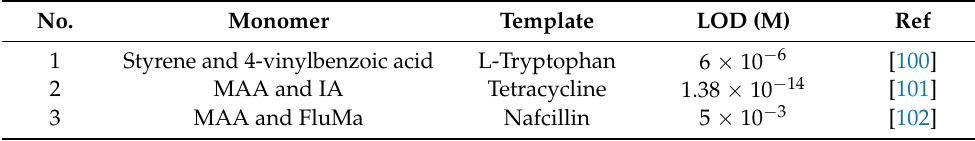
Table 2. Dual-Functional Monomer MIP Applications as